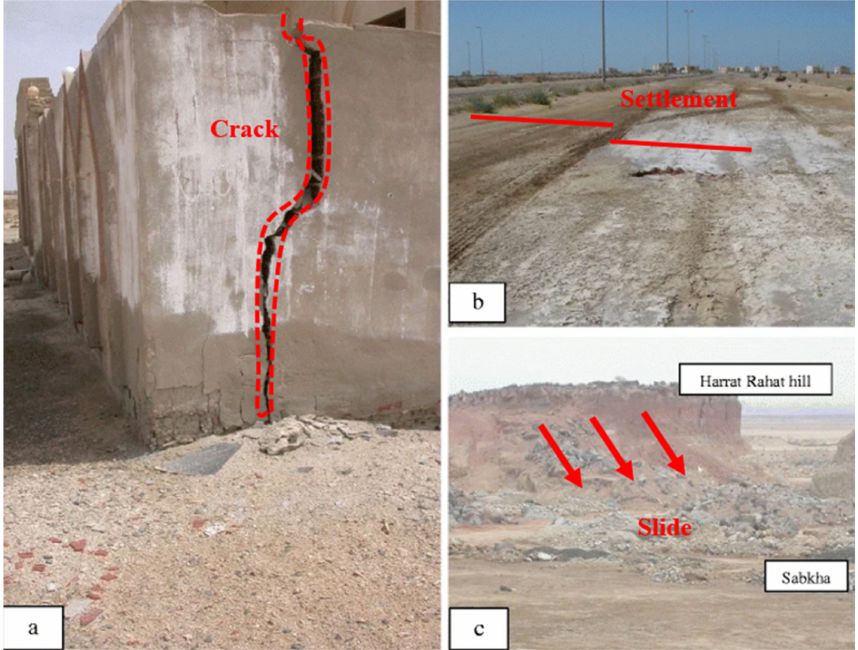
Figure 1. Engineering problems and geological disasters by expansive soil: ( a ) differential settlement of building foundation; ( b ) subgrade settlement; ( c ) landslide. Adapted from